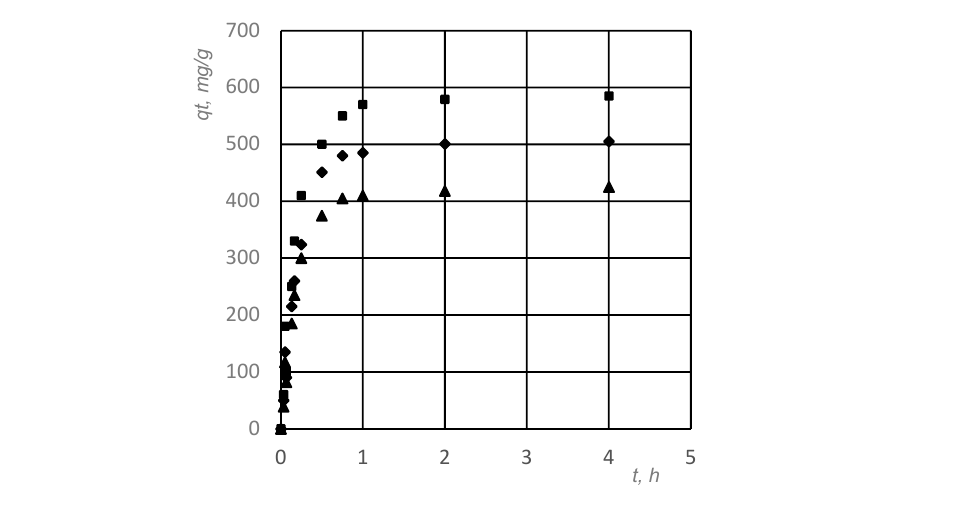
Figure 7. The influence of contact time on diazepam concentration uptake by activated charcoal for different sorbent particle sizes; T = 37.0 ± 0.1 °C; pH = 6.80 ± 0.05; C i = 0.7 mg/mL; ■ D < 10 μ m; ◆ 10 μ m < D < 15 μ m; ▲ 15 μ m < D < 18 μ m; and S:L ratio = 1 g/L.